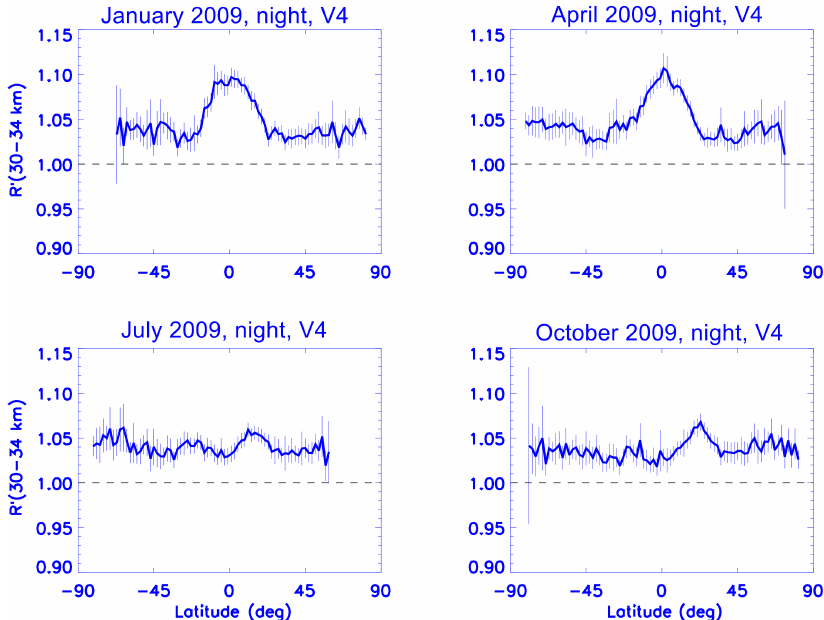
Figure 12. Zonally and vertically (over 30–34km) averaged R (cid:48) calculated from V4 CALIOP attenuated backscatter data for January, April, July and October 2009. The data are binned over 2 ◦ in latitude. The SAA region and bins with fewer than 50 points were not included.